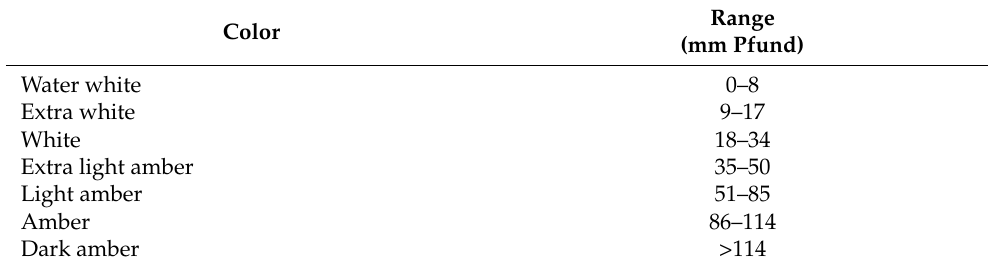
Table 2. USDA (United States Department of Agriculture) Universal Color Scale (mm